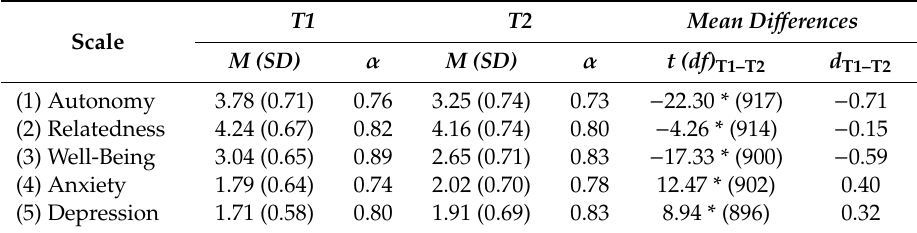
Table 1. Scale Means, Standard Deviations, Reliabilities, and Cohen’s